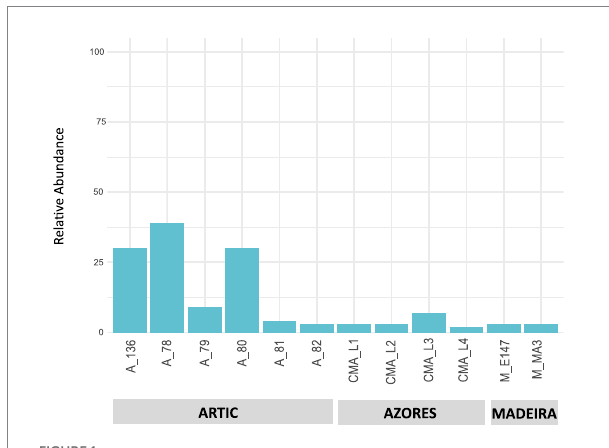
FIGURE 1 Taxonomic diversity and relative abundance at the phylum level of bacteria from the deep-sea sediment samples. Unassigned sequences and phyla comprising <2% of the total number of ASVs were classified as “Other.”